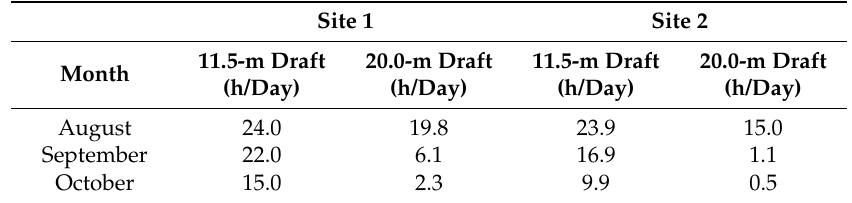
Table 5. Time duration below salinity criterion of 0.34 ppt at site 1 and site 2 with 0-m SLR with river channel accommodating vessels with 11.5-m and 20.0-m